Question: What does this figure show? Answer in one sentence.
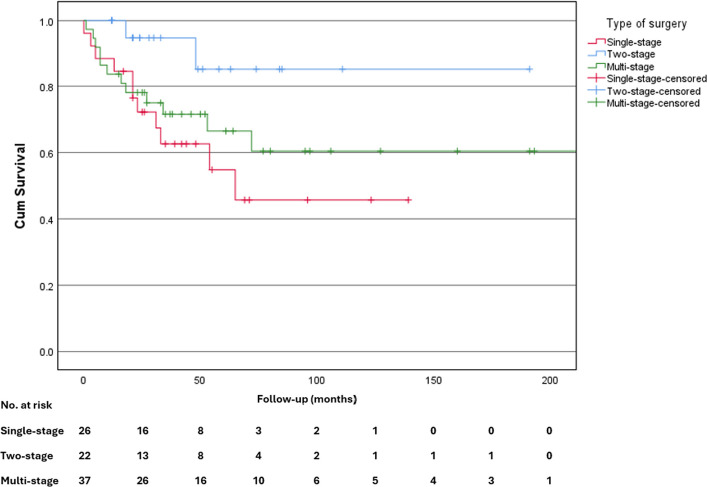
Answer: Kaplan–Meier analysis on overall implant survival. (= partial/total replacement of arthrodesis or above the knee amputation) comparing the type of surgery. Two-stage revision provided significantly better outcomes in comparison to single-stage revision (HR: 0.2 (95% CI 0.05–0.98); p = 0.048). There was no significant difference between single- and multi-stage revision (HR: 0.7 (95% CI 0.3–1.6); p = 0.395) and two- and multi-stage revision (HR: 3.6 (95% CI 0.8–15.9); p = 0.097)